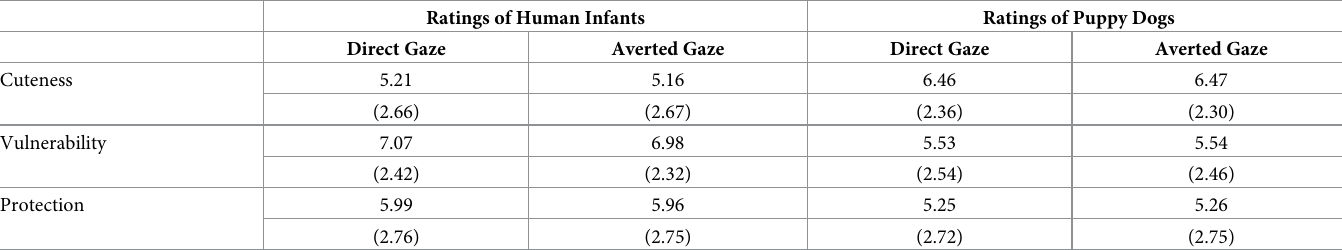
Table 5. Mean ratings (with standard deviations in parentheses) of human infants and puppy dogs, as a function of whether their eye gaze was direct or